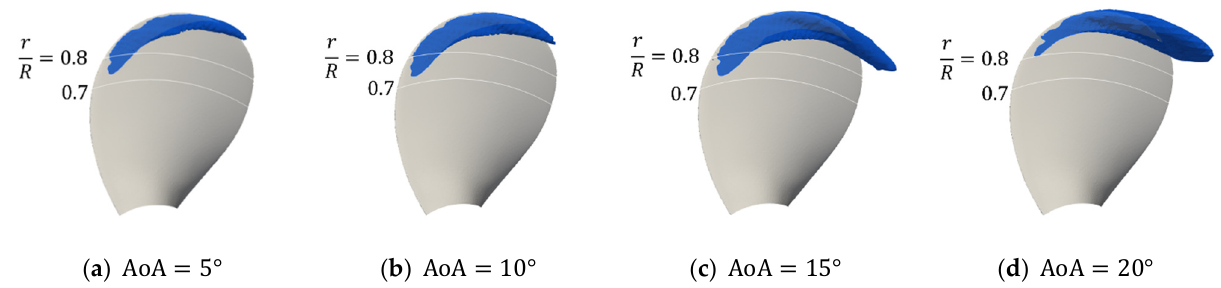
Figure 13. Cavitation of cases with D D = D P . Figure 14 represents the thrust and torque coefficients for different angles of attack.